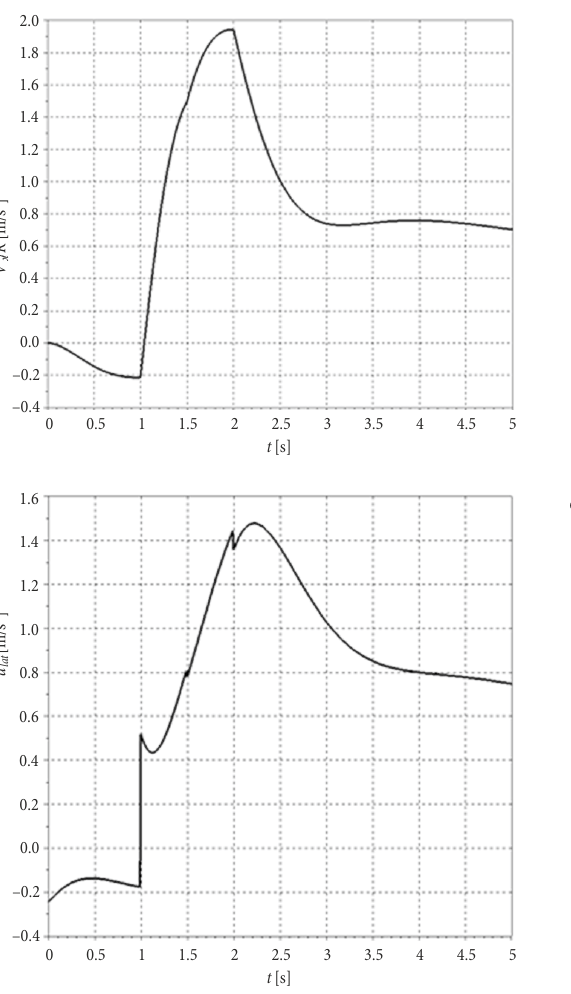
Fig. 6. Transient bicycle model results for scenario 3: a – lateral acceleration due to direction change of V x ; b – lateral acceleration cause by tiredeformation; c – total lateral acceleration; d – path radius against time